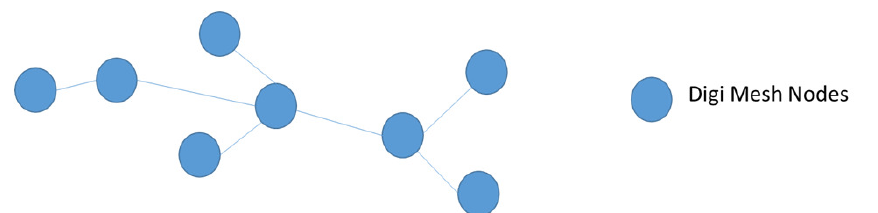
Figure 2. DigiMesh